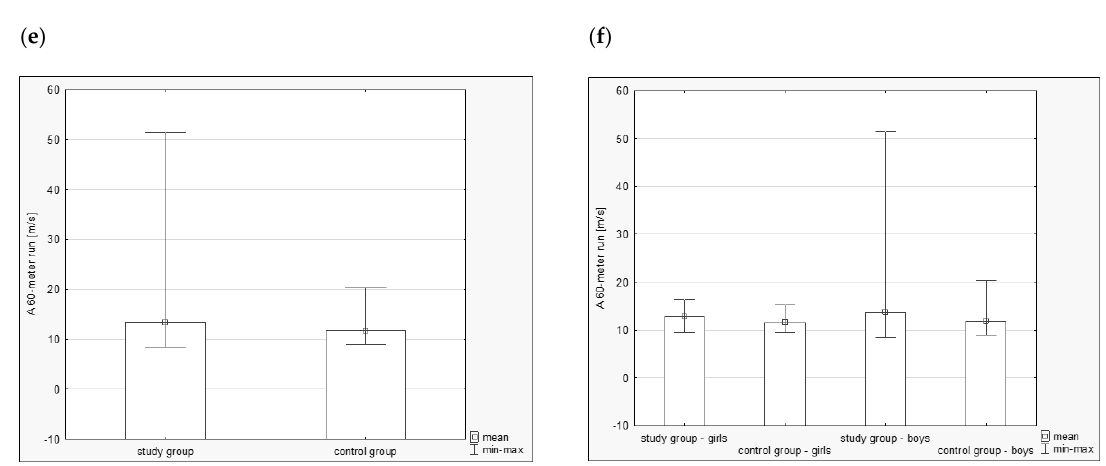
Figure 3. ( a ) Ball throw in the study groups. ( b ) Ball throw in the study groups according to sex. ( c ) Long jump in the study groups. ( d ) Long jump in the study groups according to sex. ( e ) A 60 m run in the study groups. ( f ) A 60 m run in the study groups according to sex.